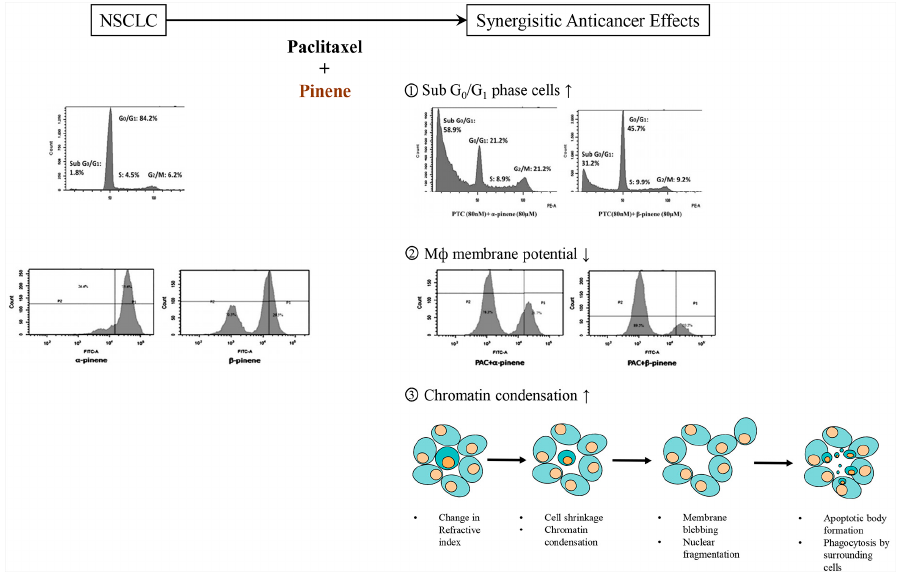
Figure 10. α - and β -pinene have synergistic anticancer effects against non-small cell lung carcinoma (NSCLC) when co-administered with paclitaxel (Modified from Zhang et al. 2019 [79]). ↑ : increasing; ↓ : decreasing